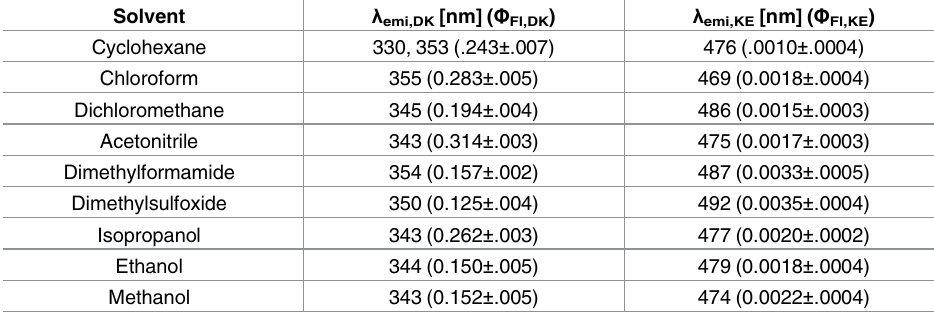
Table 4. Fluorescence emission maximaof